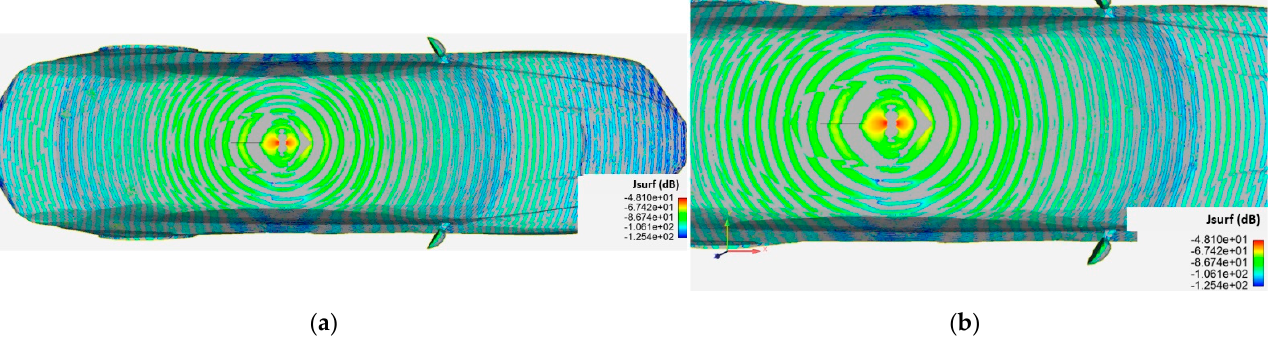
Figure 5. Differential surface current distribution imagery between the two simulation cases on a logarithmic scale generated by Ansys HFSS software and displayed using Ansys ENSIGHT: ( a ) distribution across the entire vehicle; ( b ) magnified view of the distribution at the top of the vehicle where the monopole was installed.